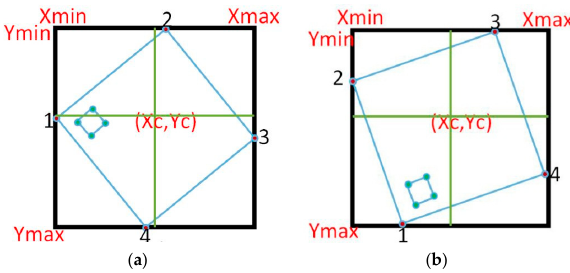
Figure 7. Illustration of marker detection ( a ) inner corners are located in two adjacent quarters; ( b ) inner corners are located in one